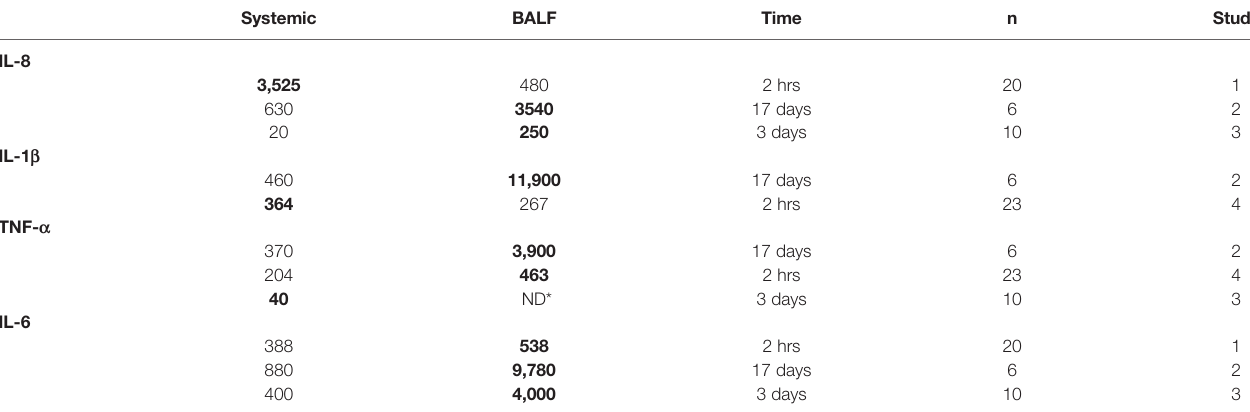
TABLE 2 | Systemic and bronchoalveolar lavage fl uid (BALF) cytokines in ARDS of non-pulmonary origin.